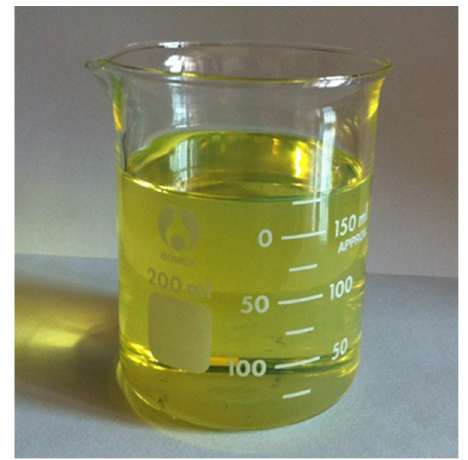
Figure A1. 0# diesel.